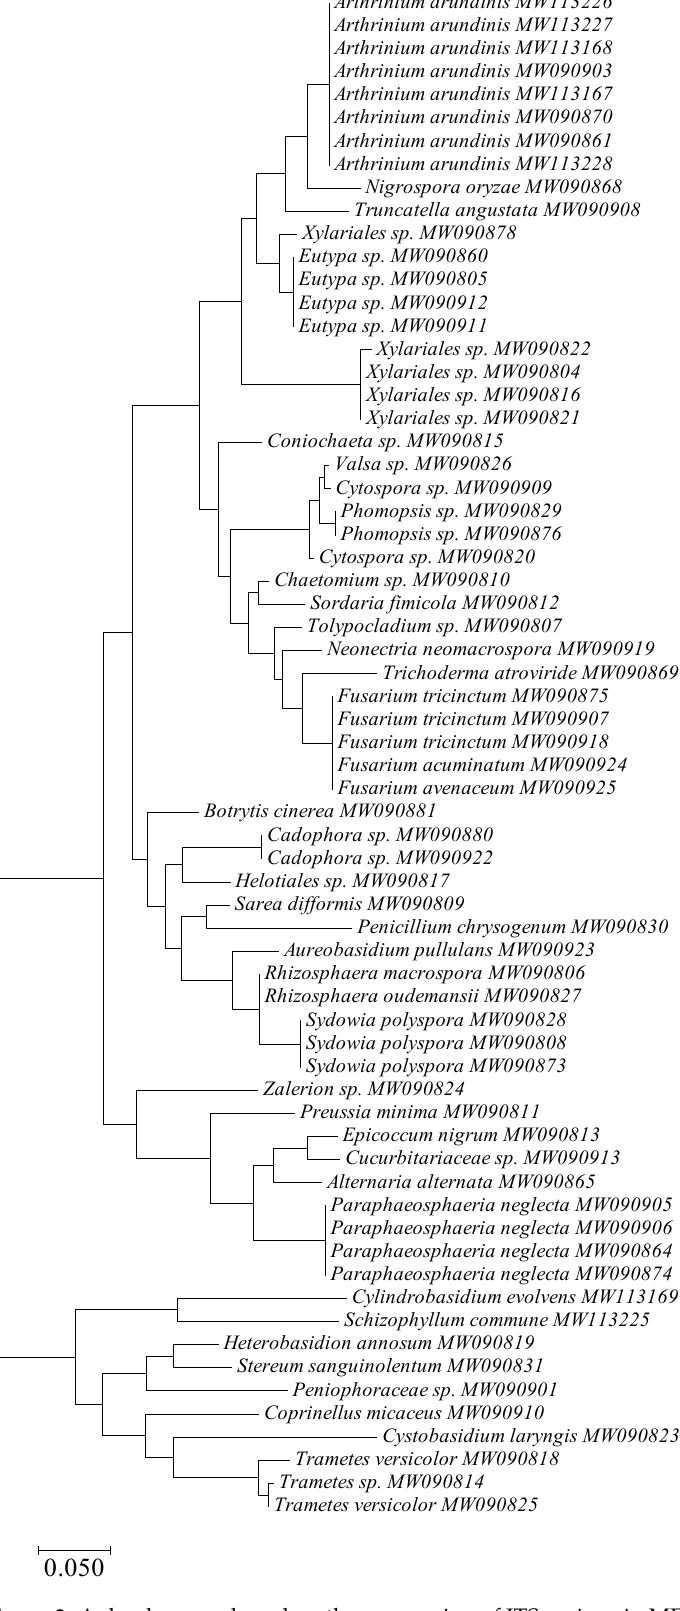
Figure 3. A dendrogram based on the sequencing of ITS regions in MEGA7 software, depicting the level of genetic similarity between 66 isolates obtained from silver fir wood in the Gorce National Park in 2020.